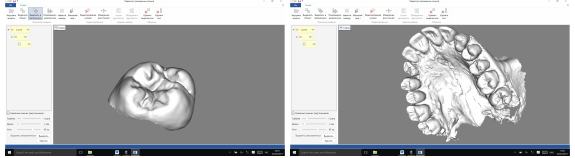
Figure 8. Upper dental arch scan and 2.7 tooth extracted from the image; individual C2